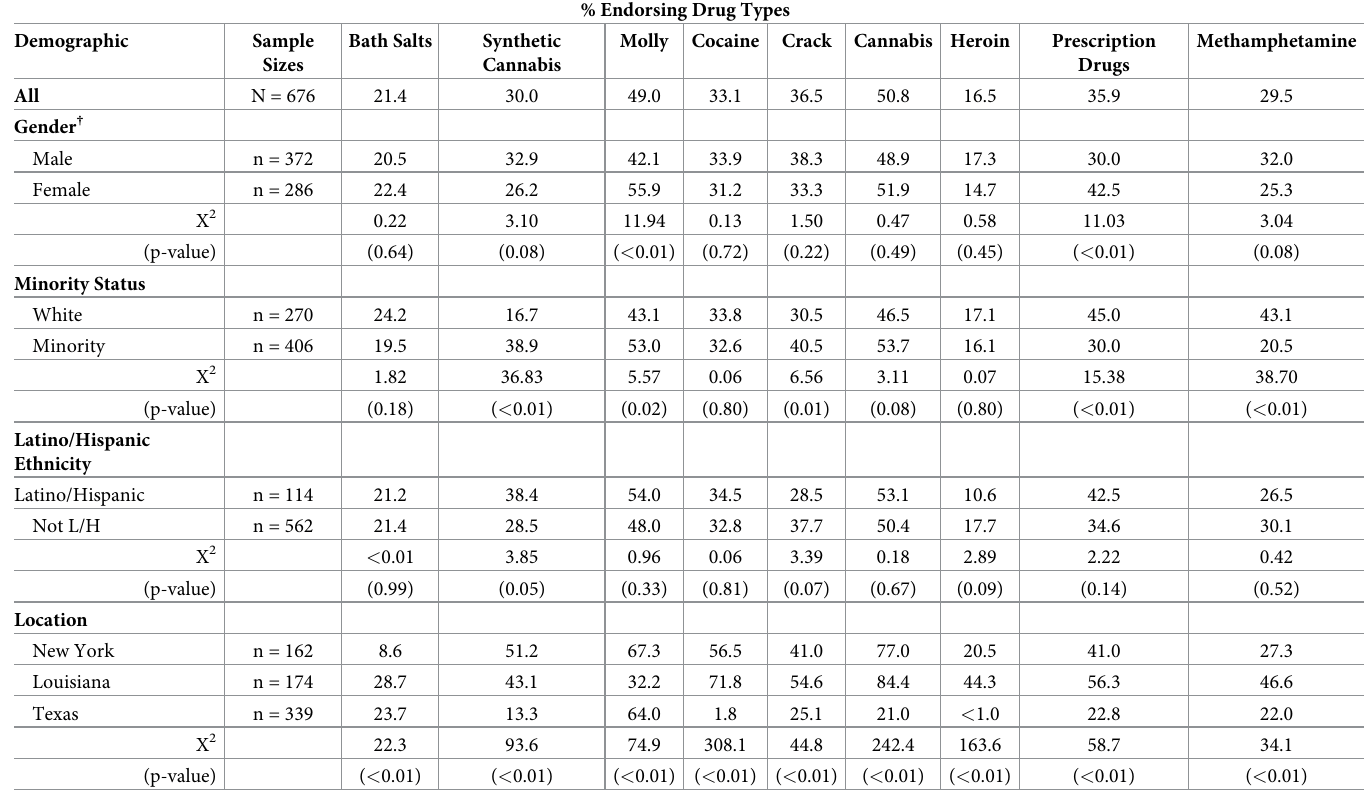
Table 3. Past 12-month drug use prevalence stratified by gender, minority ethnic status, and